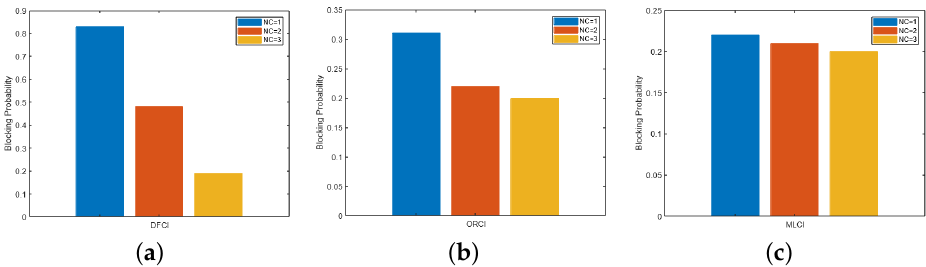
Figure 13. EVs Blocking Probability at Charging Station with Varying Number of chargers. ( a ) DC